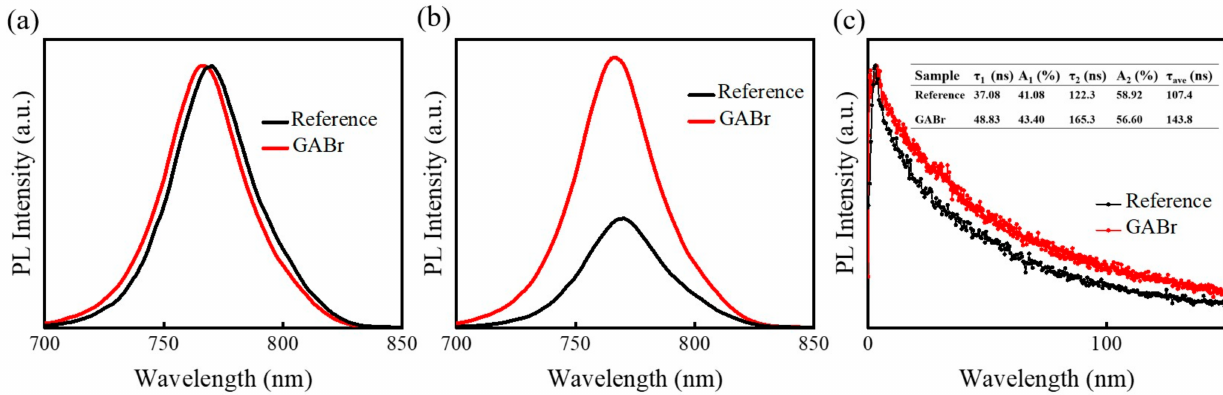
Figure 6. ( a ) The normalized Photoluminescence (PL) spectra of MAPbI 3 and GABr-treated film. ( b ) PL and ( c ) time- resolved PL (TRPL) results of MAPbI 3 and GABr-treated films, and the inset table is the corresponding parameters of the fitting